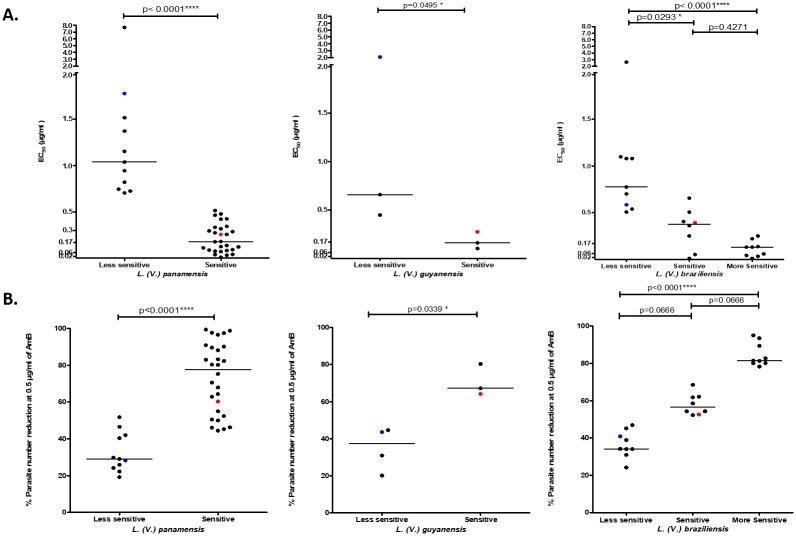
In vitro susceptibility to AmB of clinical Leishmania Viannia isolates according to the classification of the susceptibility profiles.A) Distribution of EC50 values according to the susceptibility classification for each of the species: from left to right, L. (V.) panamensis, L. (V.) guyanensis and L. (V.) braziliensis. B) Distribution of the percentages of parasite reduction according to the classification of susceptibility for each of the species: from left to right, L. (V.) panamensis, L. (V.) guyanensis and L. (V.) braziliensis.